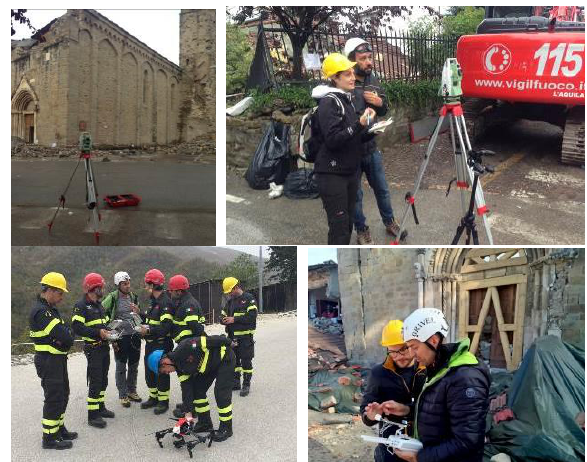
Figure 4. Survey operation in the area of Sant Agostino; The RPAS group of the Firefighters with the INSPIRE 1; Remote control of the UAV during the image acquisition phase.